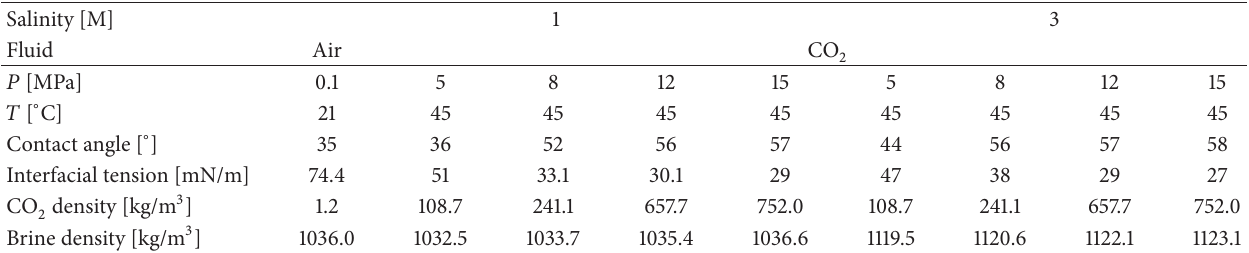
Figure 1: Experimental setup for capillary pressure-water saturation curve test. Table 1: Fluid-dependent system properties related to our experimental conditions (Jung and Wan [31]; Bachu and Bennion [35]; Kestin et al. [58]; Fenghour et al.